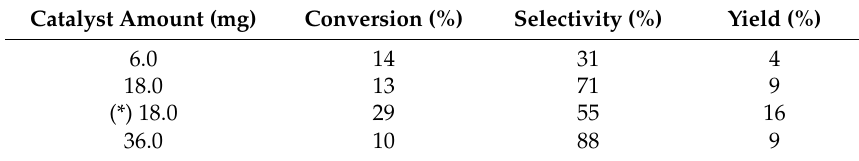
Table 4. E ff ect of the fructose concentration on TiO 2 -SO 3 H catalyst performances. Catalyst Amount (mg) Conversion (%) Selectivity (%) Yield